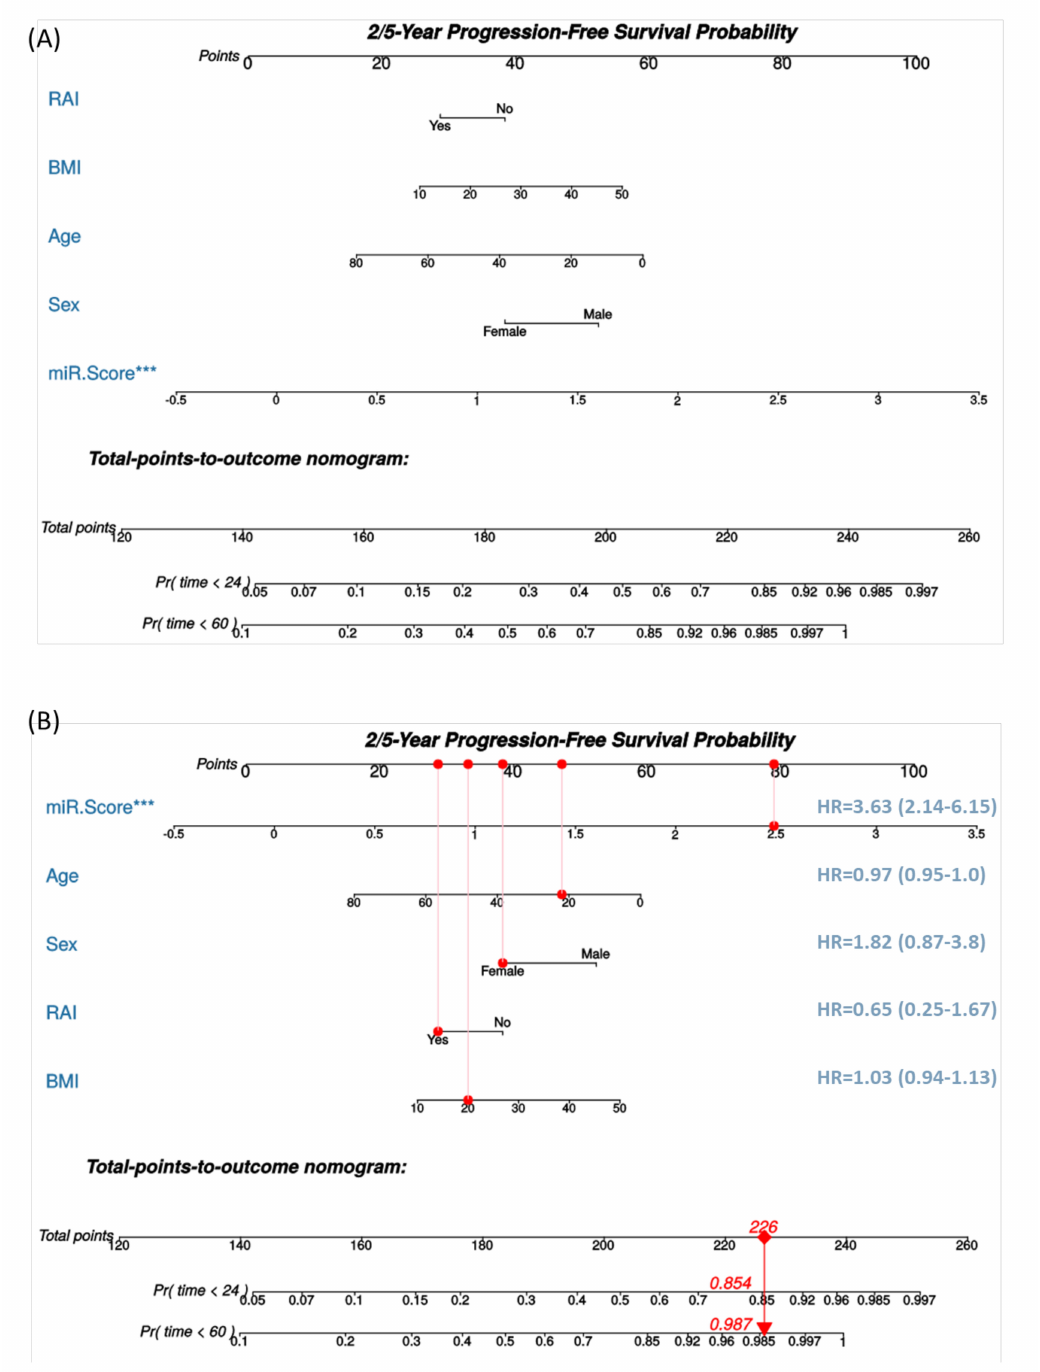
Figure 6. A nomogram for thyroid cancer prognosis. ( A ) Nomogram is predicting 2- and 5-year progression-free survival. The current nomogram is derived from well-differentiated thyroid cancer cohorts who underwent surgery at a single center. The outcome measured was a post-operative progression. Cox proportional hazard model was applied. ( B ) Example for using the nomogram. Assumed having a 20-year-old female patient with a body mass index (BMI) of 20 Kg/m 2 , whose tissue microRNA risk score was high at 2.5, and received radioactive iodine (RAI) ablation. Each variable will be scored on its points scale. The scores for all variables are then added to obtain the total score, and a vertical line is drawn from the total-points row to estimate the probability of survival rates within 2 years and 5 years. *** indicates p <